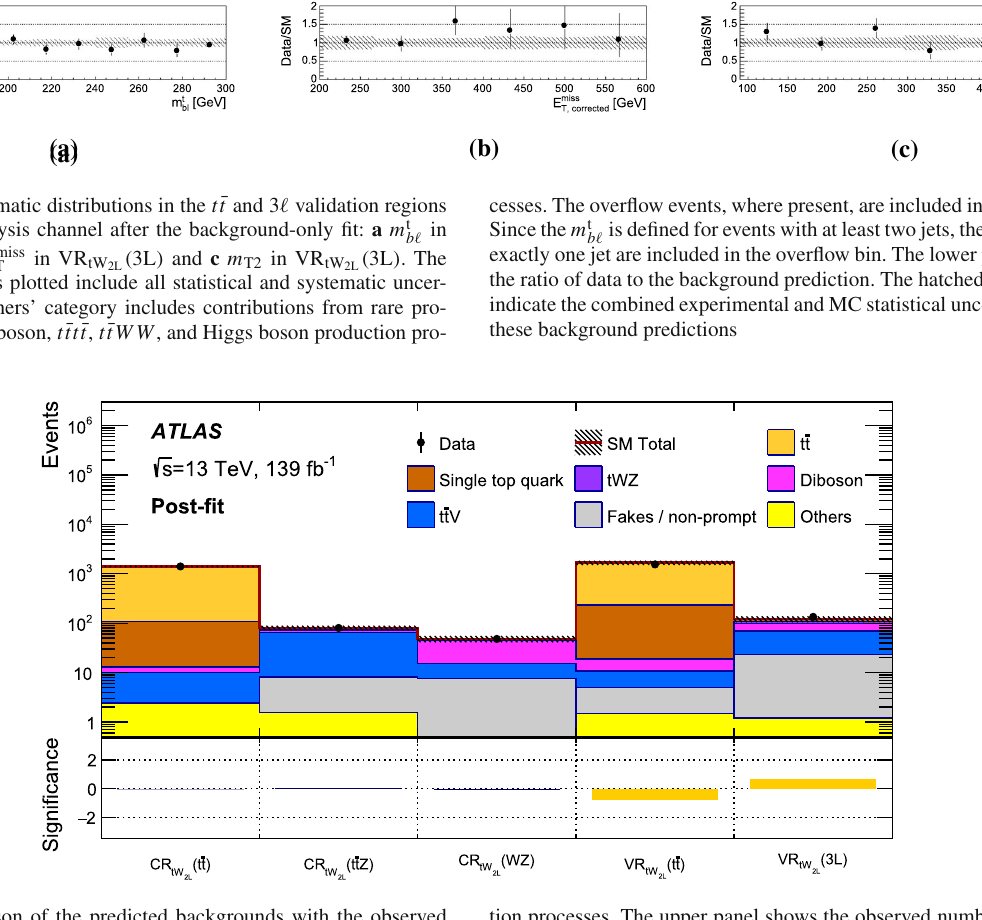
tion processes. The upper panel shows the observed number of events and the predicted background yield. All uncertainties are included in theuncertaintyband.Thelowerpanelshowsthesignificancesestimated for each